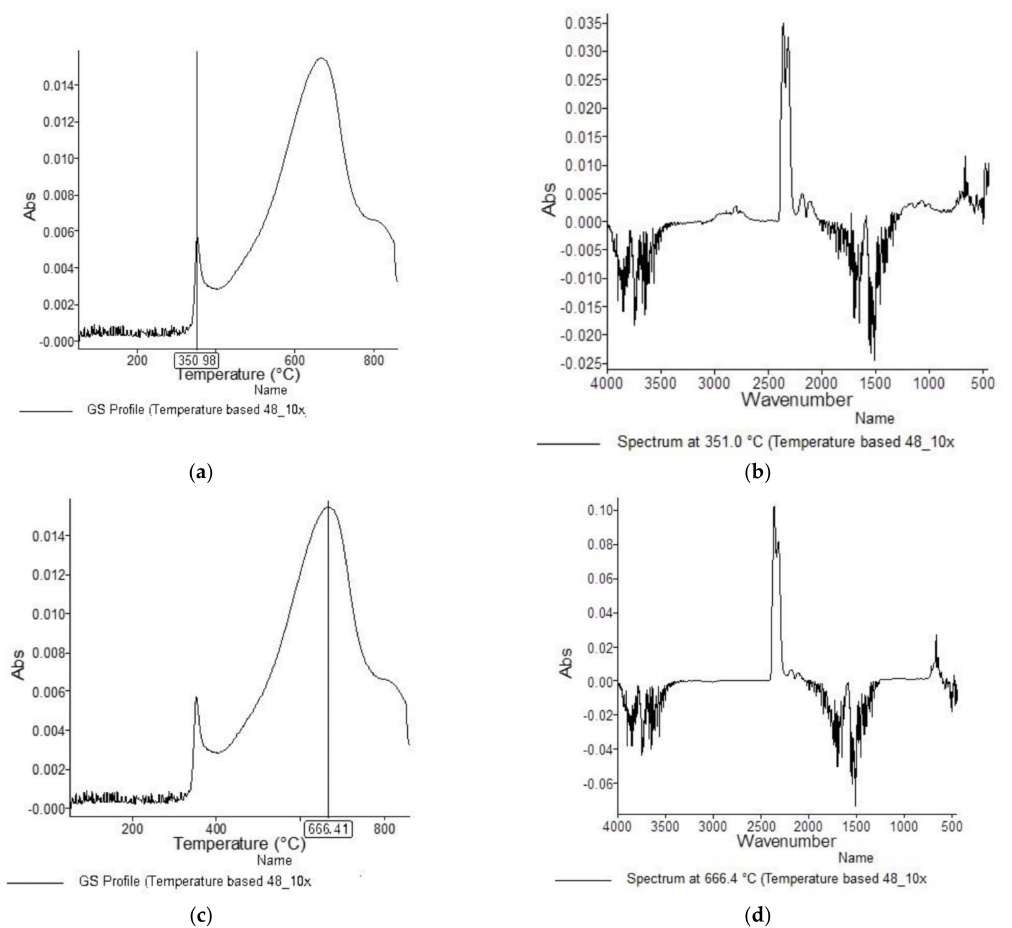
Figure 8. TG–IR analysis of 48_10x during thermo-oxidative decomposition: ( a ) and ( c ) intensity profile FT–IR spectrum of gas evolved, ( b ) FT–IR spectrum of gas evolved at 351.0 ◦ C, ( d ) FT–IR spectrum of gas evolved at 666.4 ◦ C.